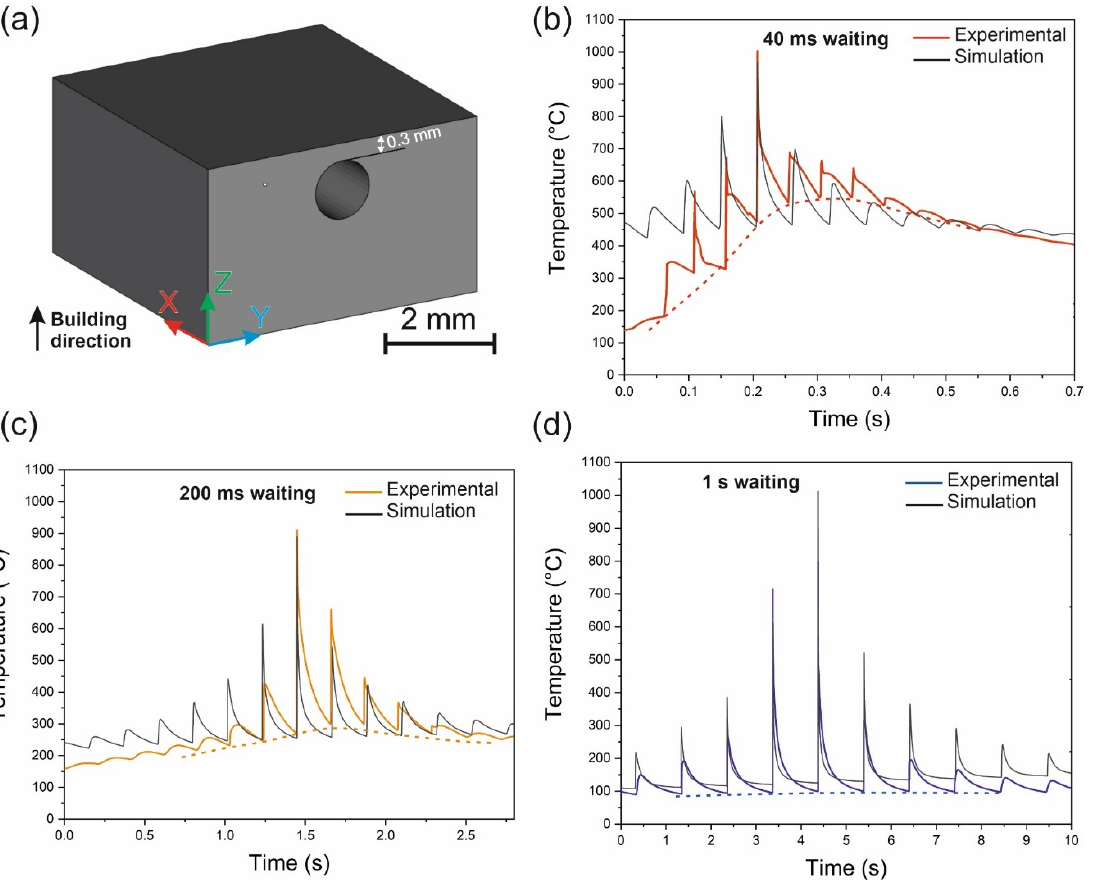
Figure 39. ( a ) Schematic of a cube with a size of 5 × 5 × 4 mm 3 containing a hole with a diameter of 1 mm and a depth of 2 mm, used to insert a thermocouple. The hole was 300 µ m below the top surface. ( b – d ) Experimental and simulated temperature evolutions related to the addition of the first layer after inserting the thermocouple, with ( b ) 40 ms waiting time, ( c ) 200 ms waiting time, and ( d ) 1 s waiting time. [80].